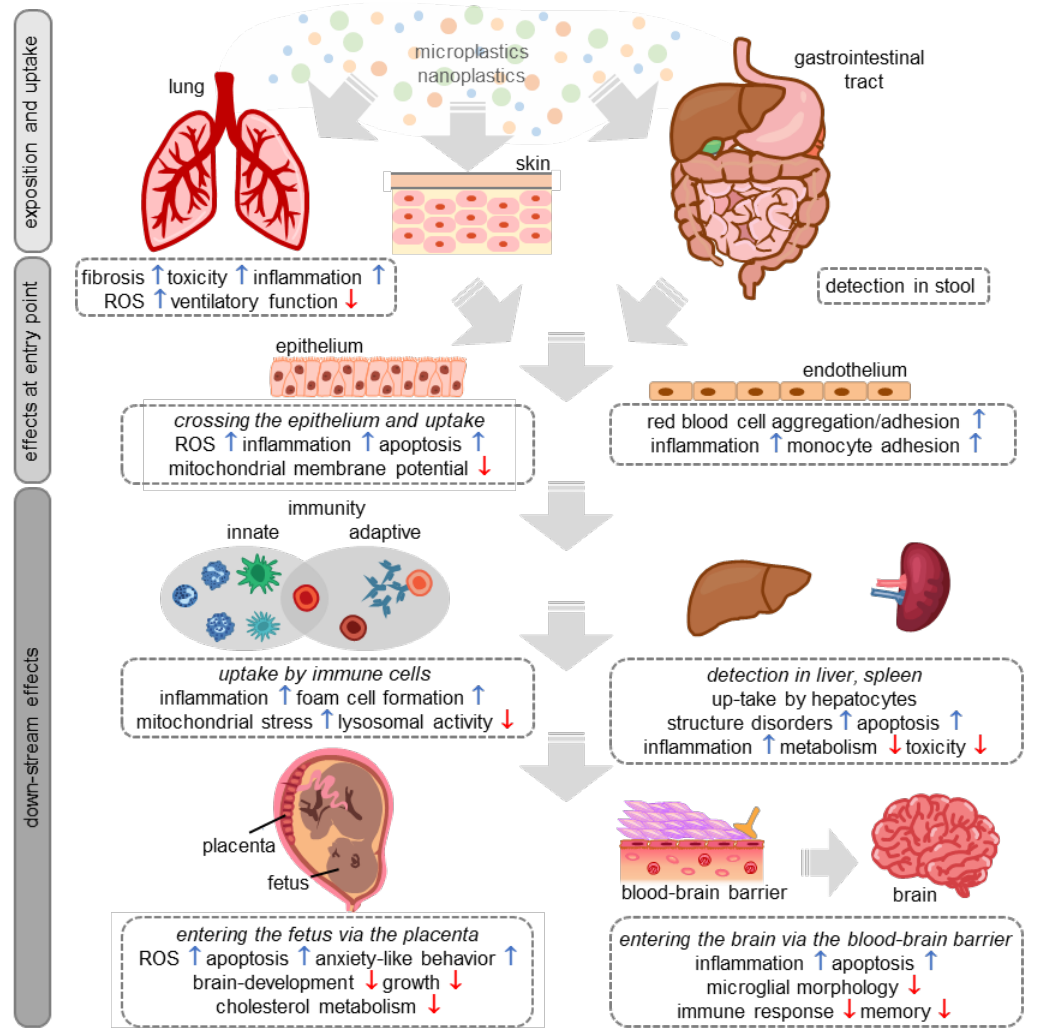
Figure 1. The schematic shows the different uptake pathways and effects of micro- and nanoplastics on different tissues, organs, and cells in mammals. ROS = reactive oxygen species.